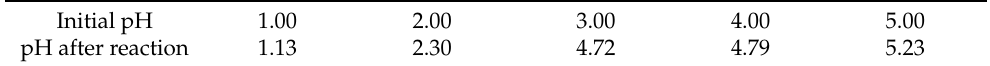
Table 1. The pH values of solution before and after T-BSA treatment.